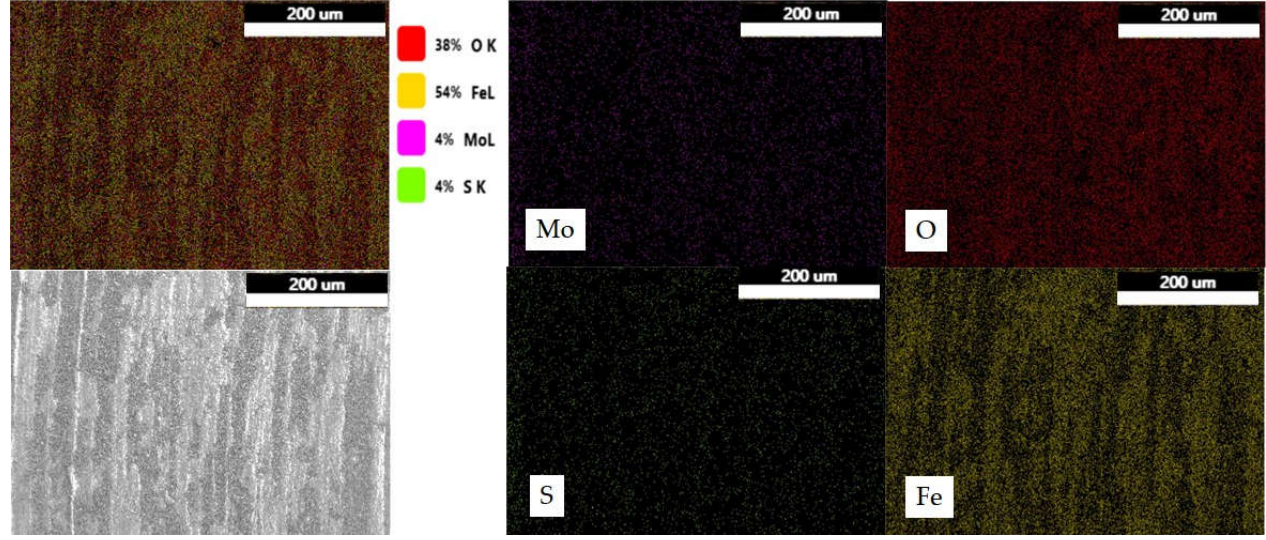
Figure 10. EDX elemental mapping of MoS 2 -coated disc after wear test at 15 N applied load and 0.75 m/s sliding speed.